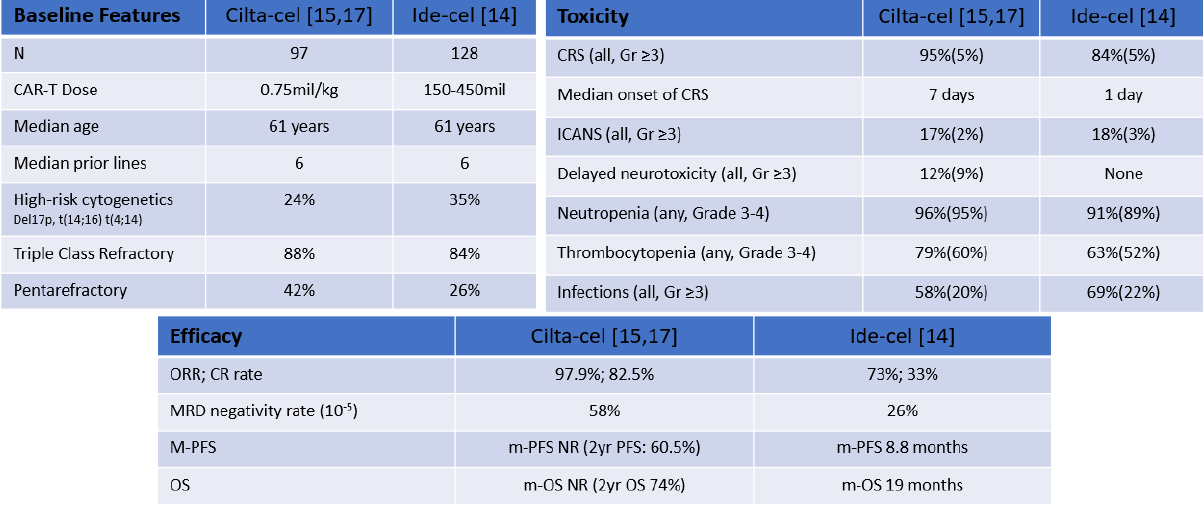
Figure 2. Comparable Features cilta-cel and ide-cel [14,15,17]. NR: not reached; m-PFS: median PFS; m-OS median OS.